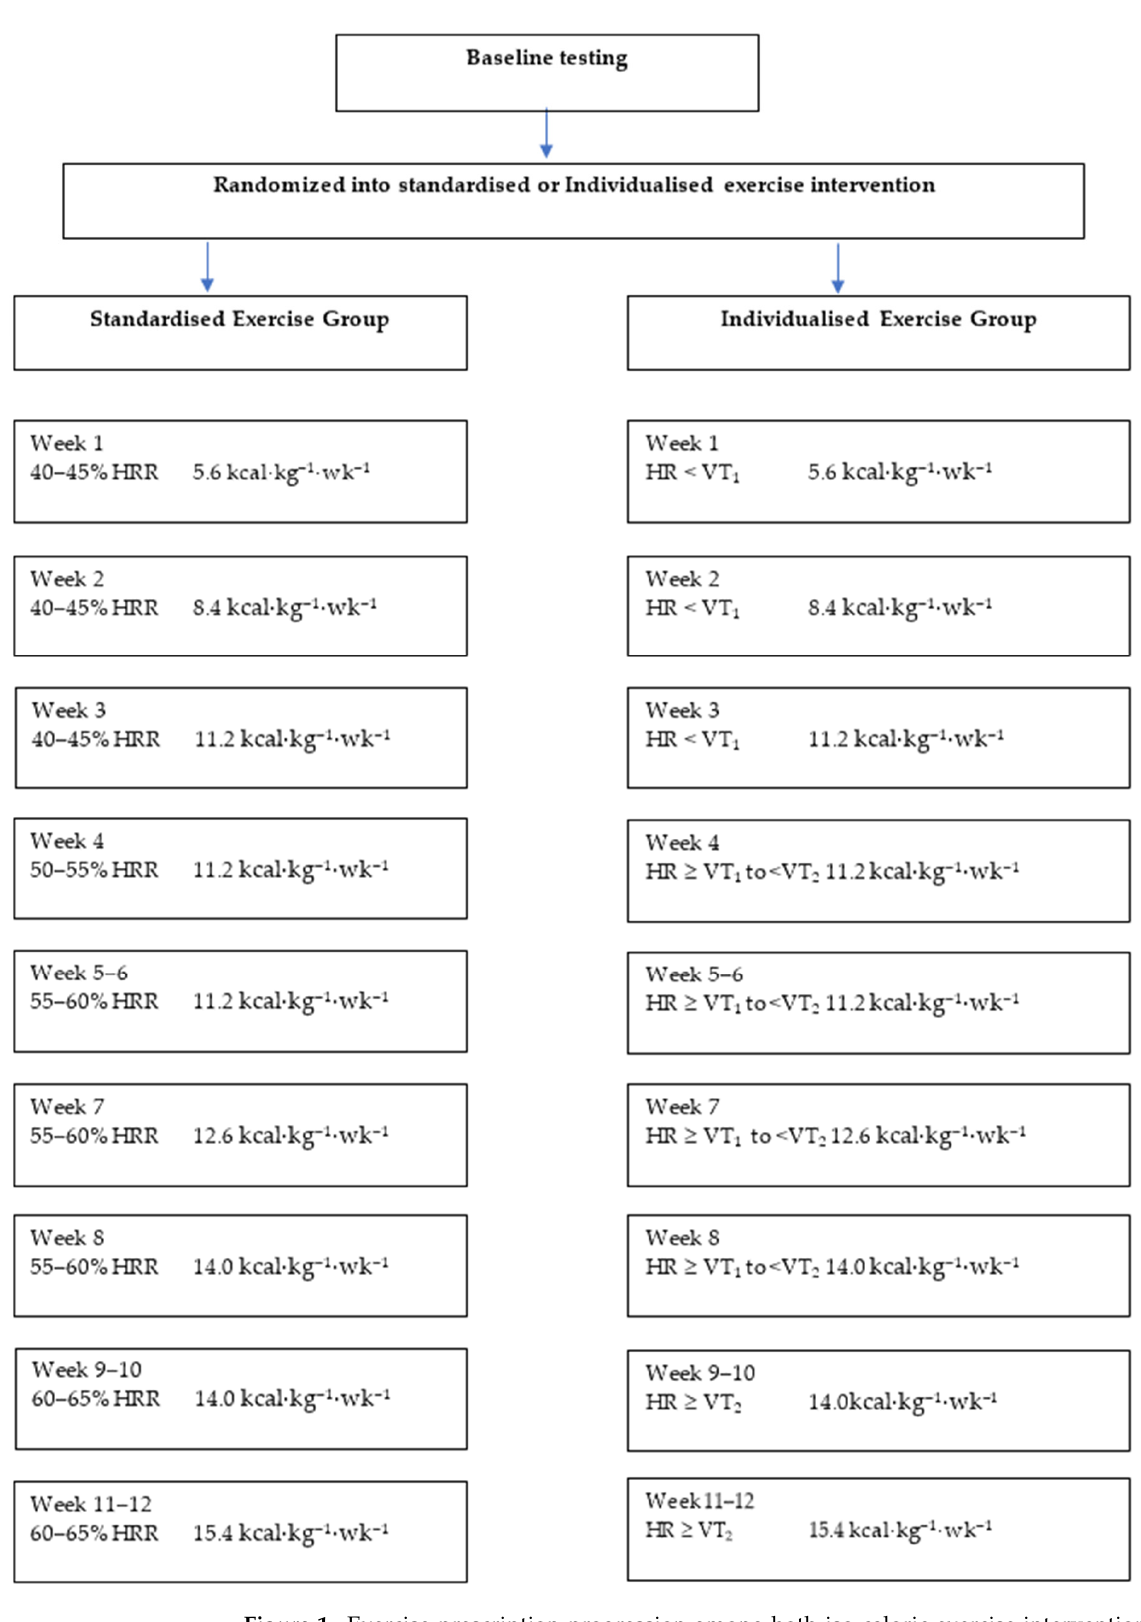
Figure 1. Exercise prescription progression among both iso-caloric exercise intervention groups throughout the intervention. HRR: Heart Rate Reserve; HR: Heart rate; VT 1 : Ventilatory threshold 1; VT 2 : Ventilatory threshold 2; Kcal: kilocalories.